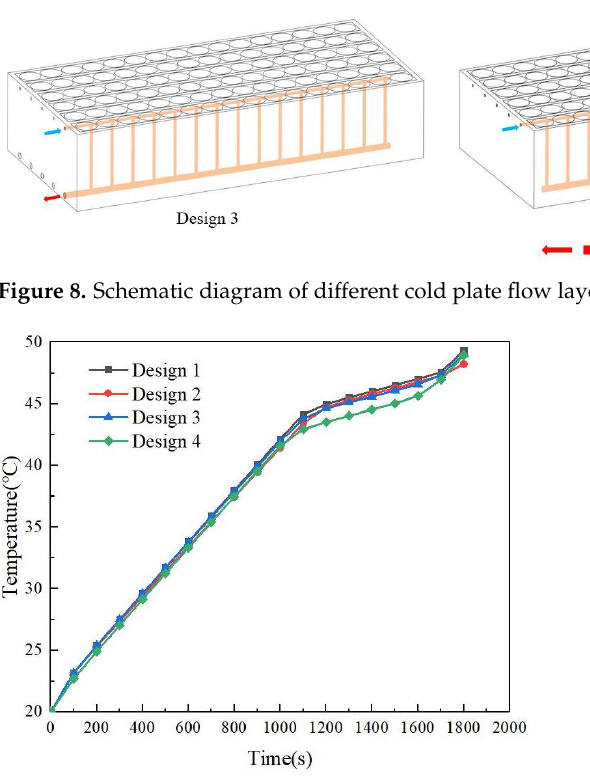
Figure 9. The evolution of battery pack T max under different cold plate layouts in a cycle. Table 3. Performance of different cold plate flow arrangements in battery modules.